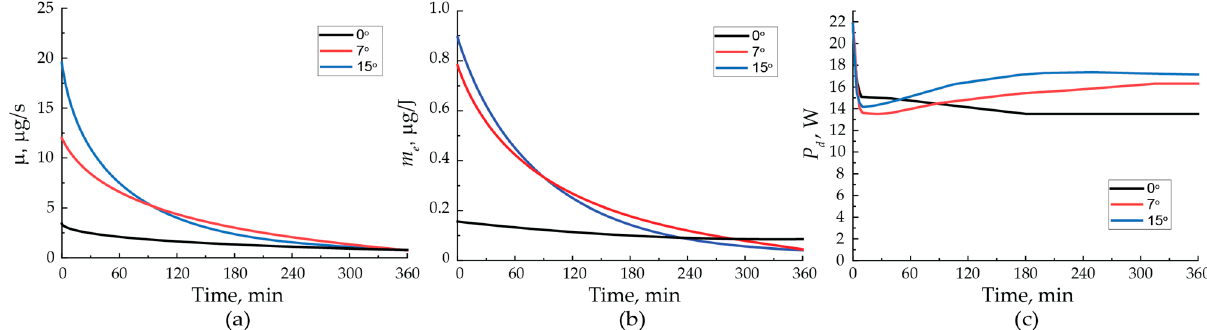
Figure 14. ( a ) The electrodes’ mass loss rate, ( b ) energy efficiency, and ( c ) power released in the spark gap for the three cases of the degree of the electrode asymmetry with the ODP.